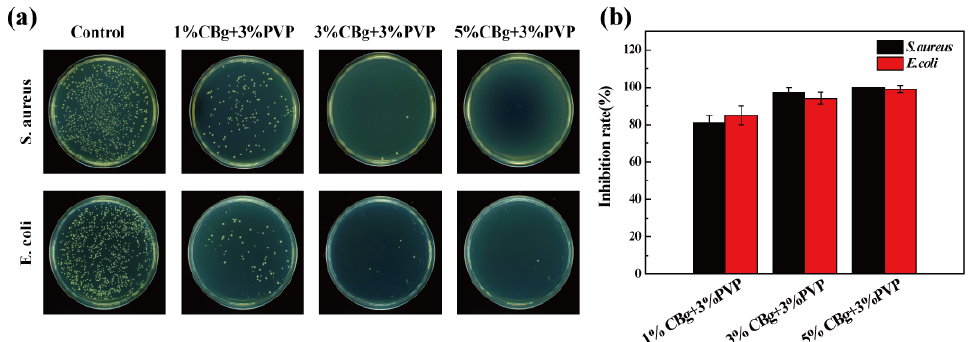
Figure 5. ( a ) Antibacterial effect of different CBg/PVP films on S. aureus and E. coli . ( b ) Inhibition rate of different CBg/PVP films.